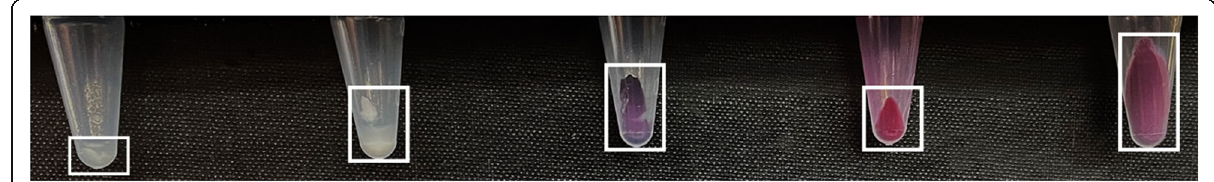
Fig. 9 Image depicting the precipitated fractions (highlighted in boxes) of 7 times diluted, centrifuged dispersions with 1:0 WPI:sucrose and 0% bioactives (Left) and 1% bioactives from pure gallotannin (Center, Left), Aronia berry extract (Center), beet extract (Center, Right), and cranberry extract (Left). *COLOR USAGE